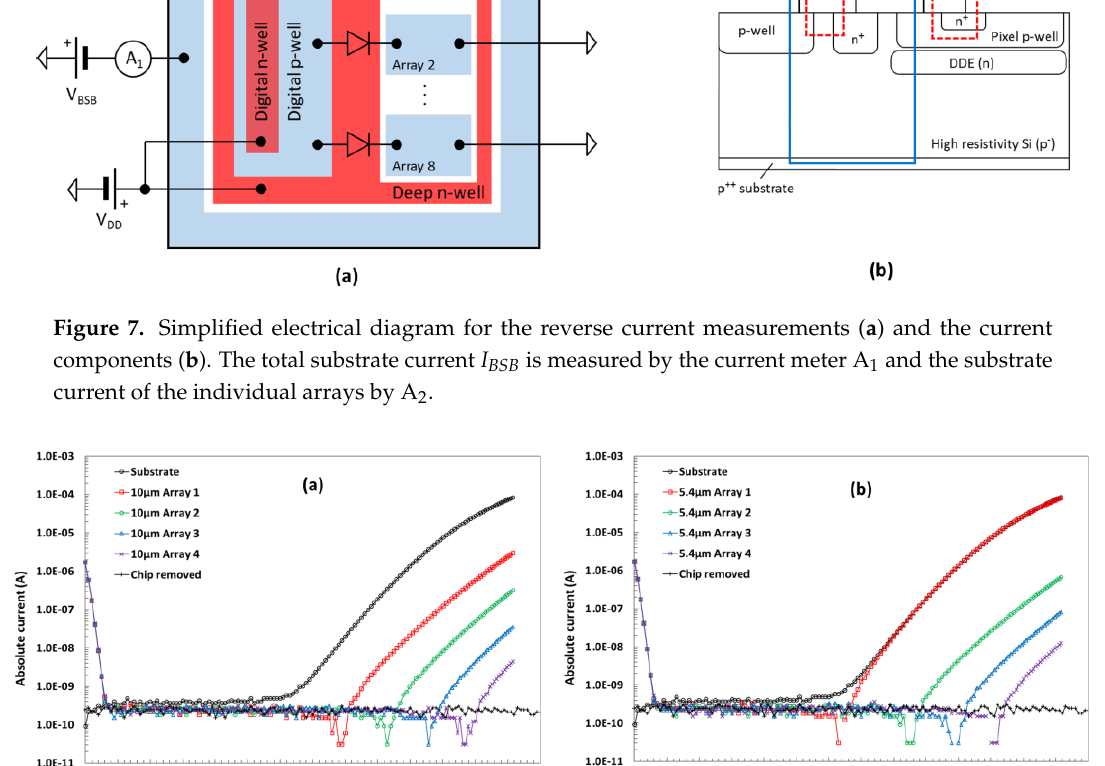
Figure 7. Simplified electrical diagram for the reverse current measurements ( a ) and the current components ( b ). The total substrate current I BSB is measured by the current meter A 1 and the substrate current of the individual arrays by A 2 .